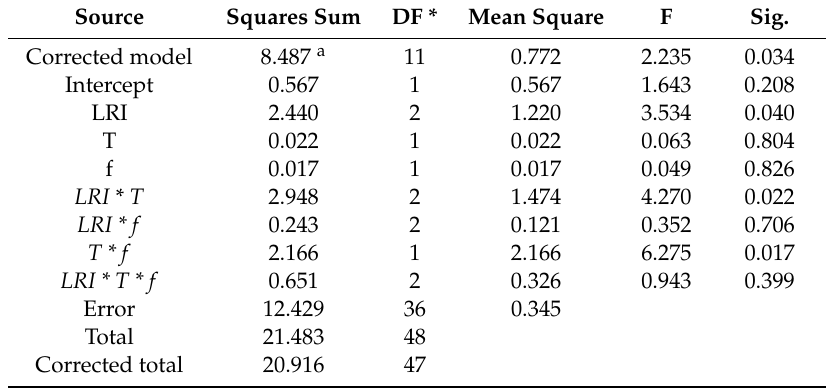
Table 10. Mg-Ti-Mg test. Last ANOVA iteration for Ln Ra values. Adapted from [18]. Source Squares Sum DF * Mean Square F Sig. Corrected model 8.487 a 11 0.772 2.235 0.034 Intercept 0.567 0.567 1.643